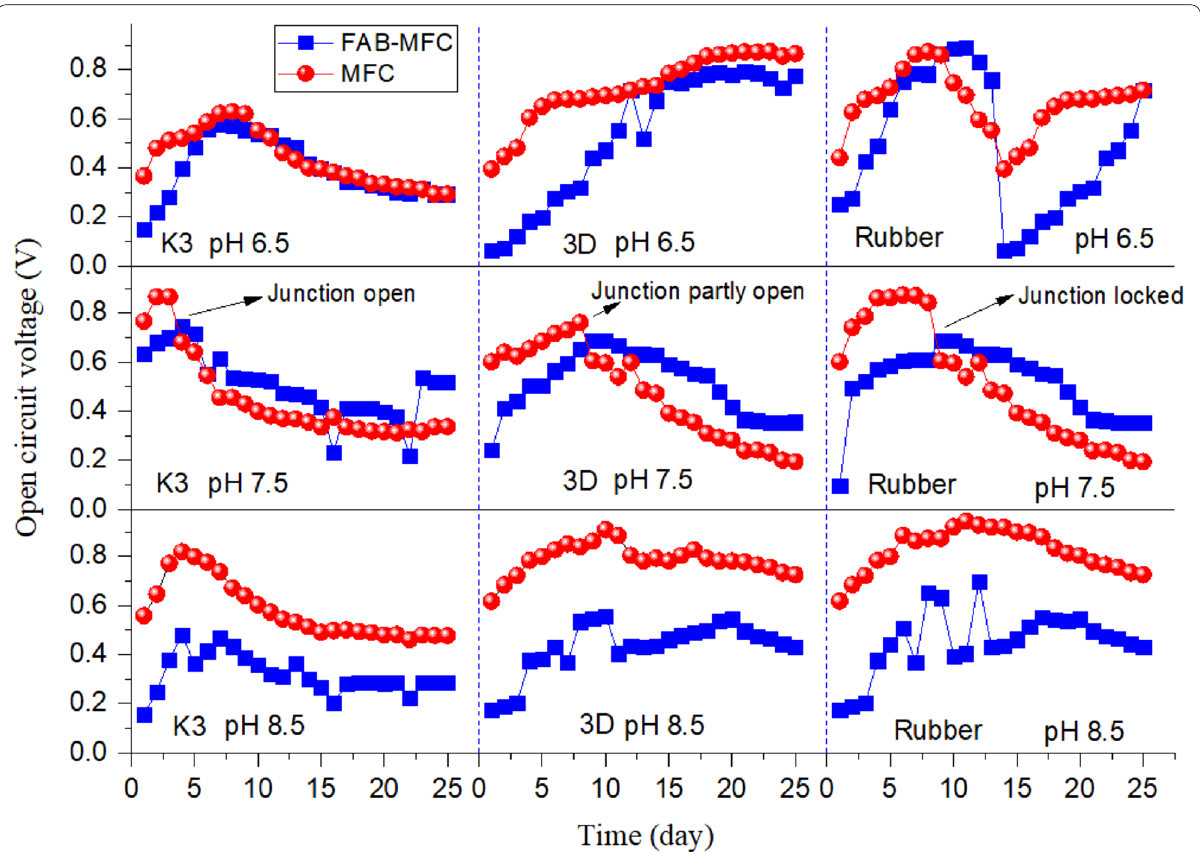
Fig. 9 Open circuit voltage (OCV) generated at different anodic pH in MFC and FAB-MFC reactor using rubber, 3D, and K3 MEJ-dish at 27 ℃ . Junction refers to the space between the electrode and MEJ-dish (where MEJ-dish was connected to the electrode); K3 (open), 3D (partly opens), and rubber lock (close) the